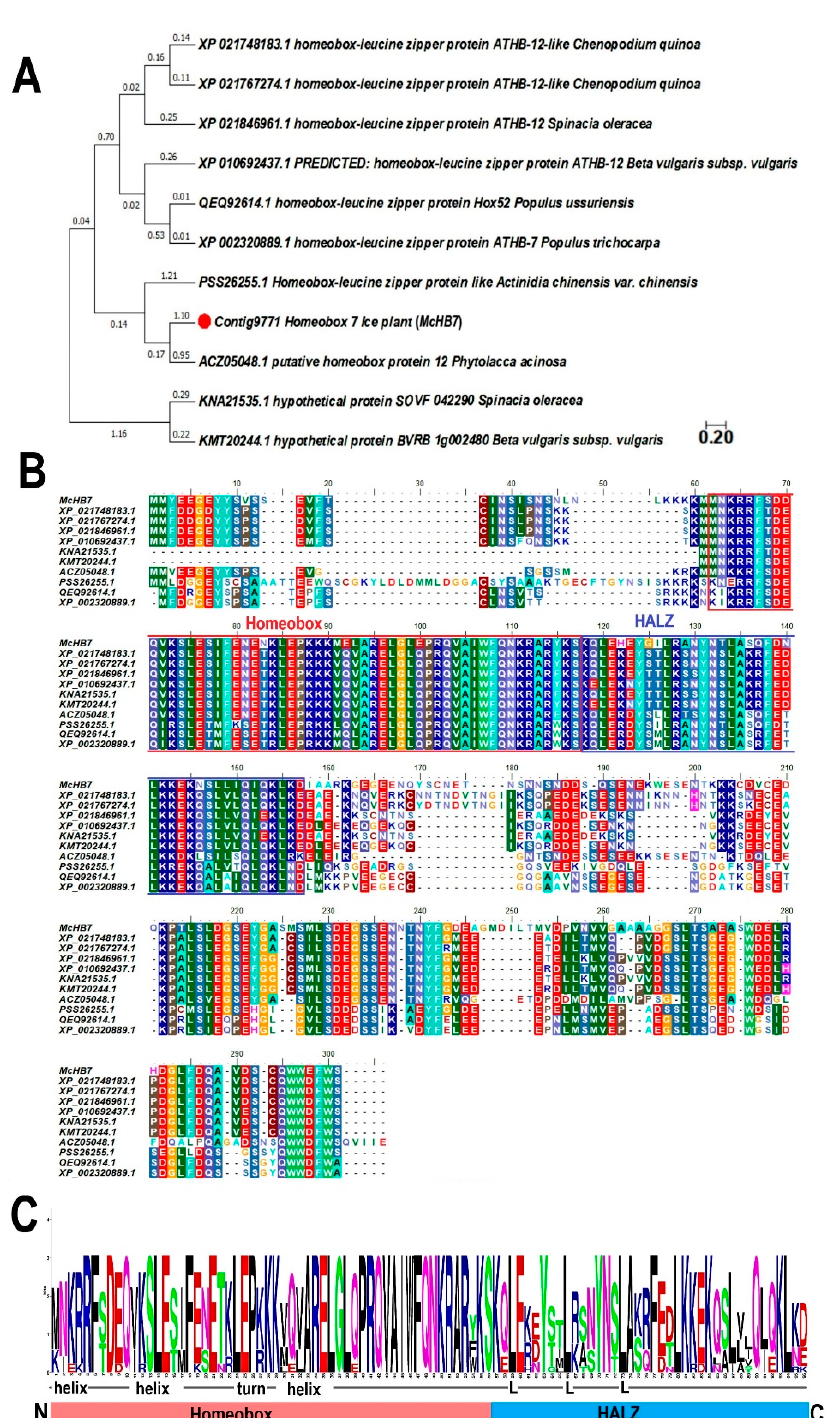
Figure 1. Bioinformatic analysis of Mc HB7 and homologous TF proteins. ( A ) Phylogenetic tree of XP_021748183.1, XP_021767274.1, XP_021846961.1, XP_010692437.1, KNA21535.1, KMT20244.1, ACZ05048.1, PSS26255.1, QEQ92614.1, and XP_002320889.1. The red dot indicates the Mc HB7 TF. ( B ) Amino acid sequence alignment of XP_021748183.1, XP_021767274.1, XP_021846961.1, XP_010692437.1, KNA21535.1, KMT20244.1, ACZ05048.1, PSS26255.1, QEQ92614.1, and XP_002320889.1. ( C ) Two domains of homeobox TFs: conserved homeobox domain (HD) and variable HALZ domain.